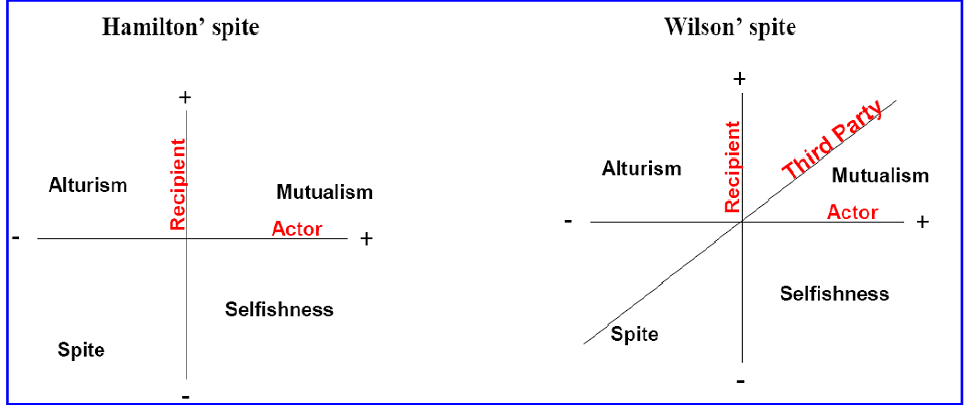
Figure 1. A comparison between the interaction spaces presented by the spite models proposed by Hamilton (left panel) and Wilson (right panel). Mutualism could be represented through the support of tumor growth by nonmalignant cells [30]. Moreover, some cancer cells become addicted to InterLeukin-3 to survive (primed cell for death) and so benefit from the immune system, and this is a kind of selfishness [31]. Yet, microenvironment acidity-induced cancer spite (MAICS) results in excessive cell death and eventually might prevent its spreadability and so it lies under the altruism umbrella because it results in an encapsulated tumor [32]. Cannibalism at the end results in death of both normal and malignant cells under the context of organismal selection so it is compatible with spite . Therefore, it would be very interesting if further studies carry on for determining how tumors handle the thresholds of the four